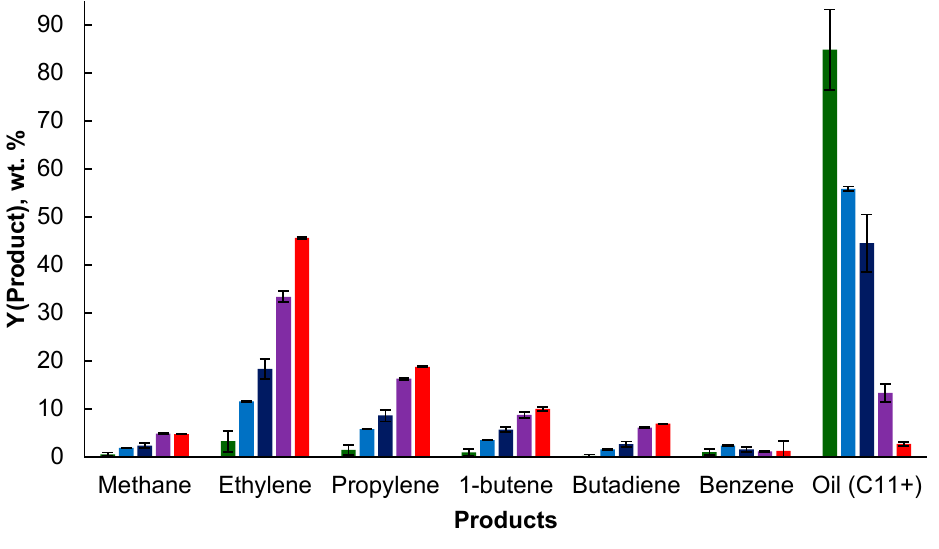
Figure 2. Selected products yield of HRSO1 pure feedstock pyrolyzed under 400 kPa, 65 NmL/min and various temperature: ■ 700 °C, ■ 725 °C, ■ 750 °C, ■ 775 °C, and ■ 800 °C.